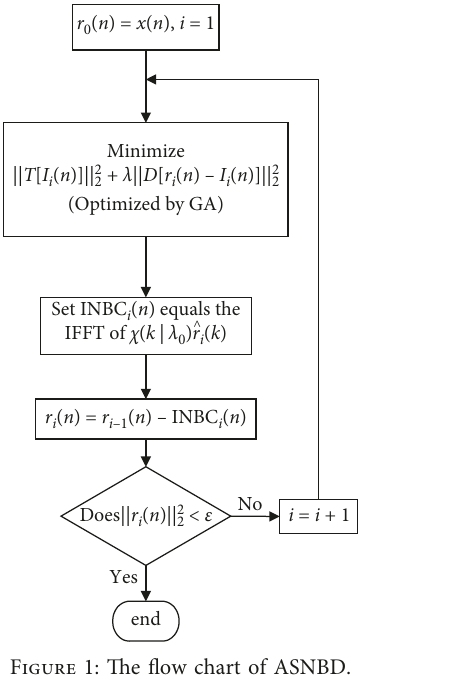
Figure 1: The flow chart of